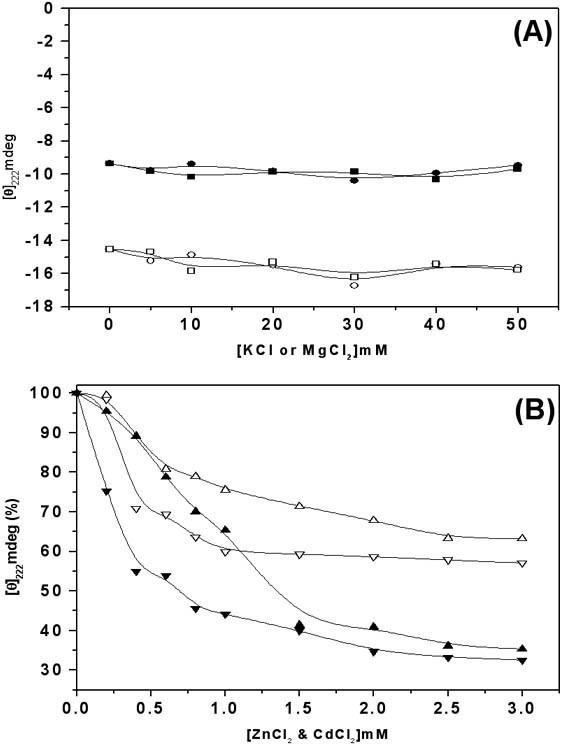
Divalent cations have differential effects on the secondary structure of MtαIPMS and TIM barrel domain. A. Effect of increasing concentration of KCl (circle) and MgCl2 (square) on the CD ellipticity at 222 nm of MtαIPMS (open symbols) and TIM barrel domain (closed symbol). B. Effect of increasing concentration of ZnCl2 (up triangle) and CdCl2 (down triangle) on the CD ellipticity at 222 nm of MtαIPMS (open symbols) and TIM barrel domain (closed symbols).